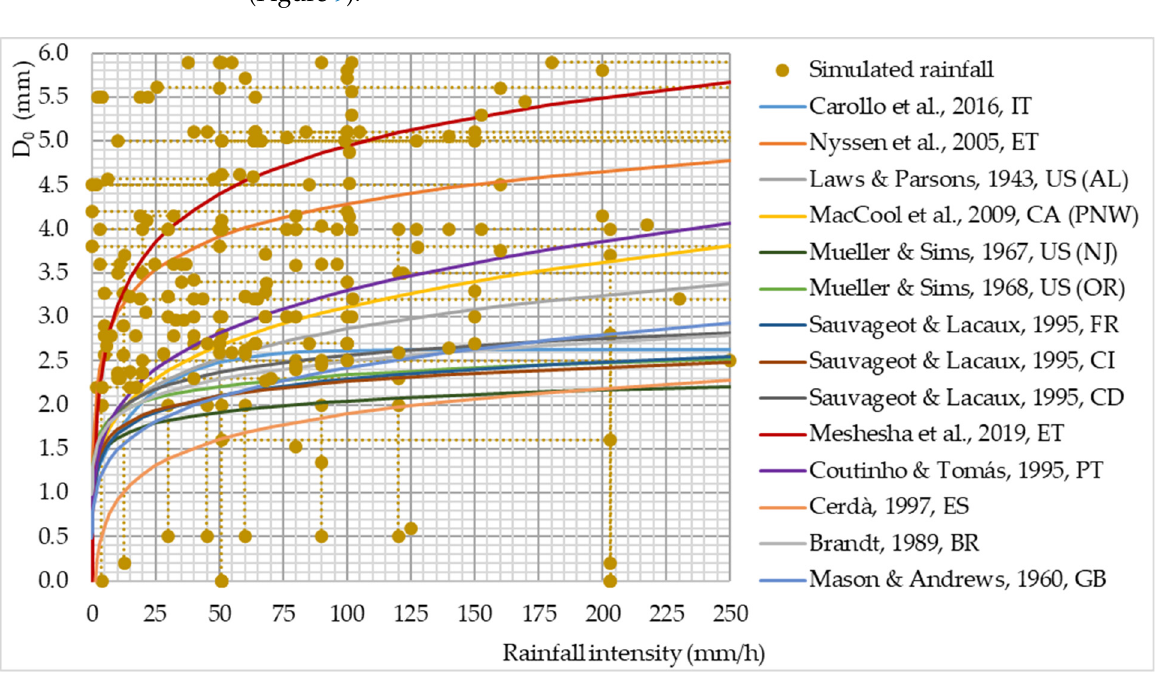
Figure 10. Number of rain simulations at different durations. Note: data whose duration values are given in ranges are not included in the analysis.